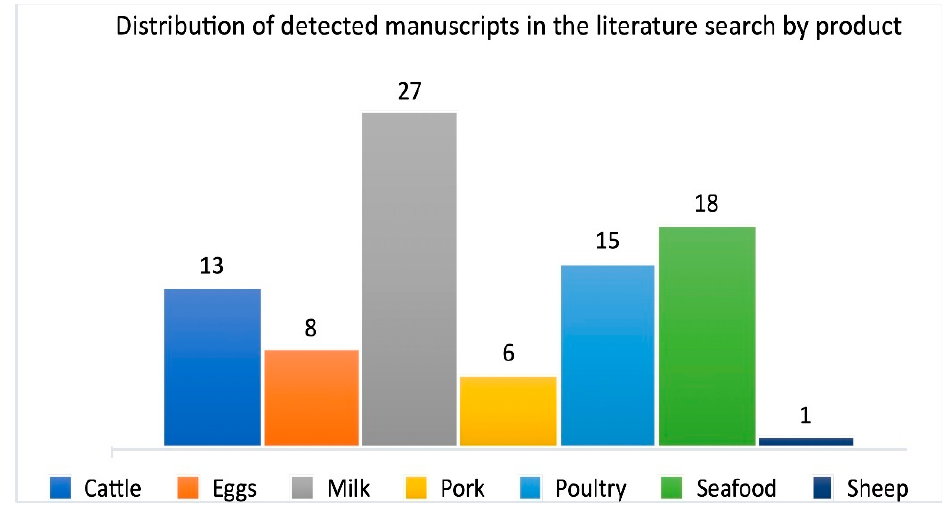
Figure 2. Distribution of manuscripts describing animal products where antibiotics still were de- tectable.